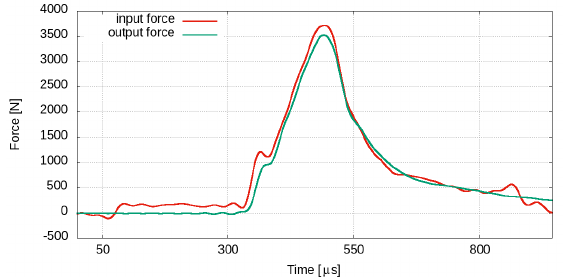
Figure 4. Force equilibrium diagram for polyurethane putty specimen tested at 1.5bar.